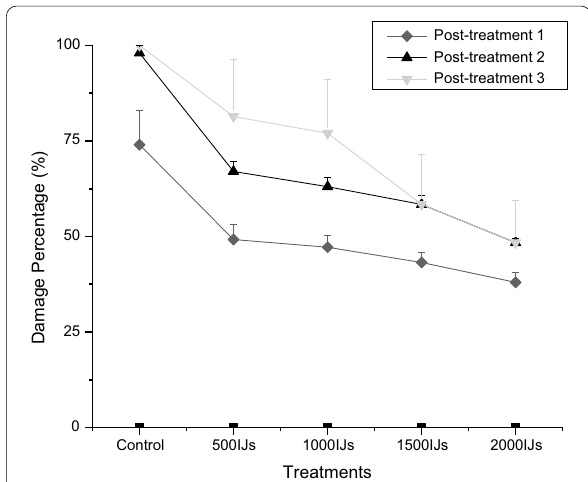
Fig. 1 Leaf damage percentage by Pieris brassicae larvae after three constitutive foliar applications of entomopathogenic nematodes under greenhouse conditions